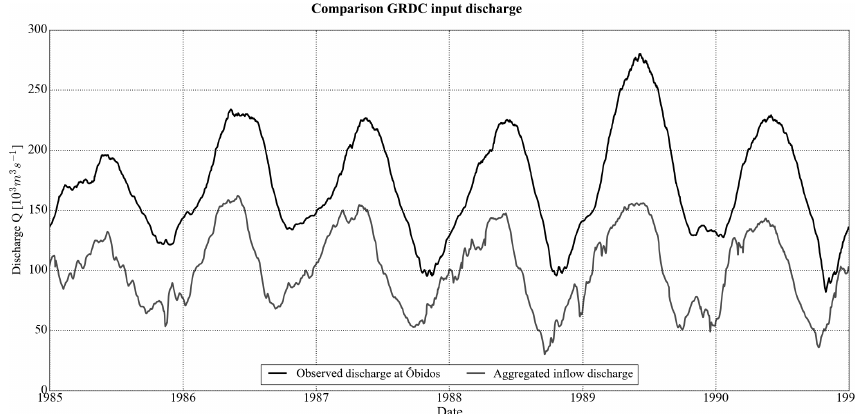
Figure 6. Comparison of input discharge aggregated over all GRDC stations upstream of Óbidos and the observed